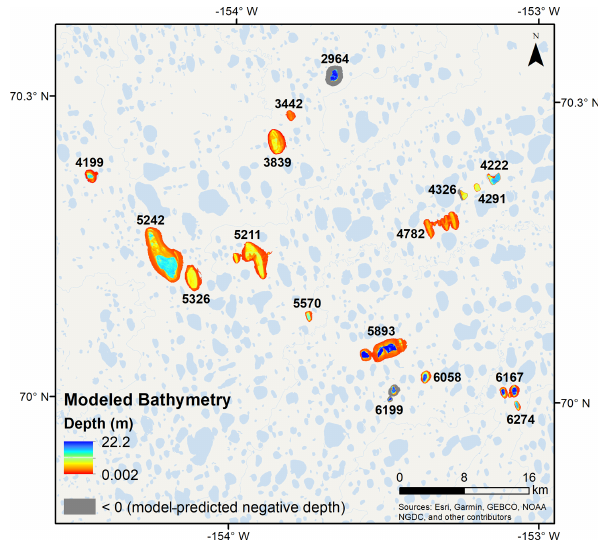
Figure 6. Bathymetry was modeled individually for each study lake and all bathymetry rasters were ultimately mosaicked together. The color bar indicates the depths predicted by the model variants at each lake; gray represents the pixels at which negative depths were modeled (these negative depths have been reclassified to − 1 in the published bathymetry raster dataset; Simpson,